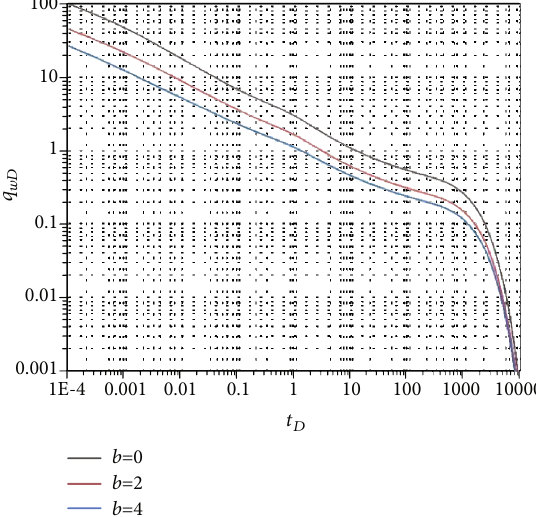
Figure 11: In fl uence of initial fracture conductivity on production.